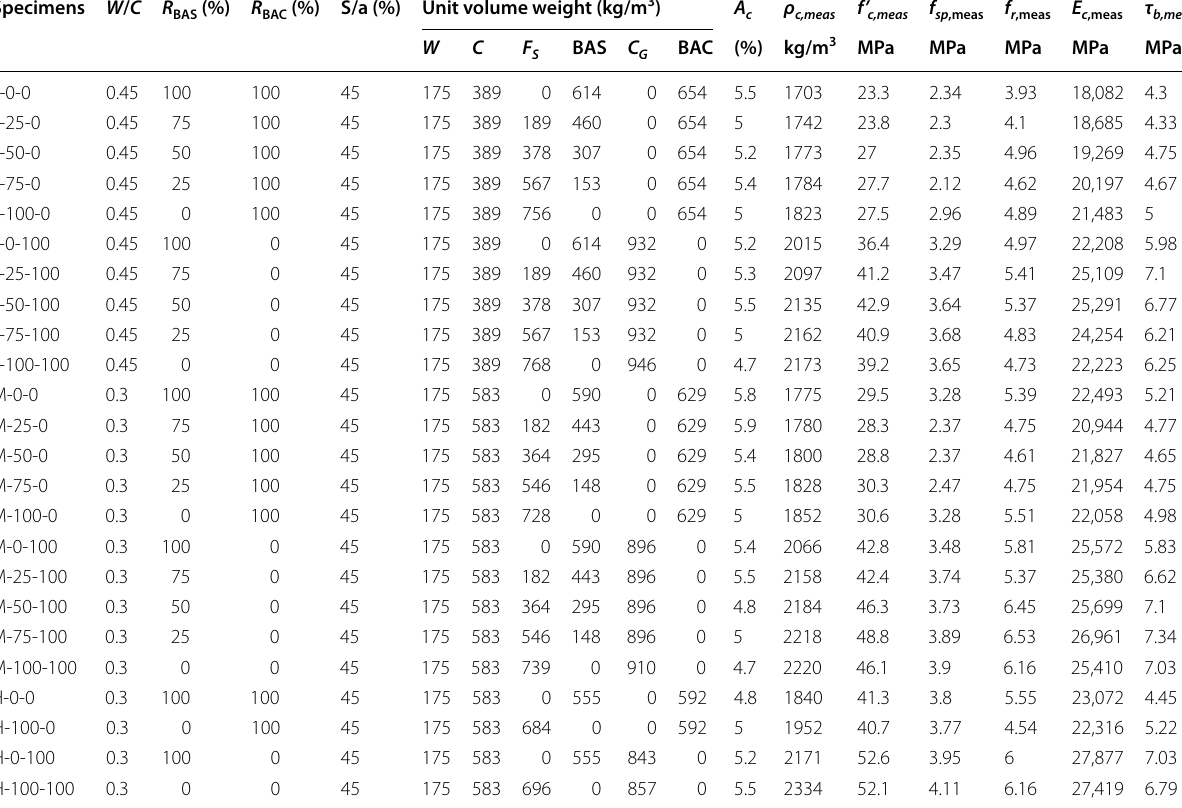
R BAS is the percentage of replaced content of BAS ( 100 BAS’s weight to total sand weight); R BAC is the percentage of replaced content of BAC aggregate = × ( 100 BAC’s weight to total coarse weight); W / C is the water-to-cement ratio; S / a is the fine aggregate ratio; W is the water volume; C is the cement; F s and C G are = × the natural sand and coarse aggregates, respectively; BAS and BAC are the bottom ash fine and coarse aggregate, respectively; A c is the air content; and ρ c,meas , f’ c,meas , f sp ,meas , f r ,meas , E c ,meas , and τ b,meas are the measured density, compressive strength, splitting tensile, modulus of rupture, elastic modulus, and bond strength at 28 days, respectively.